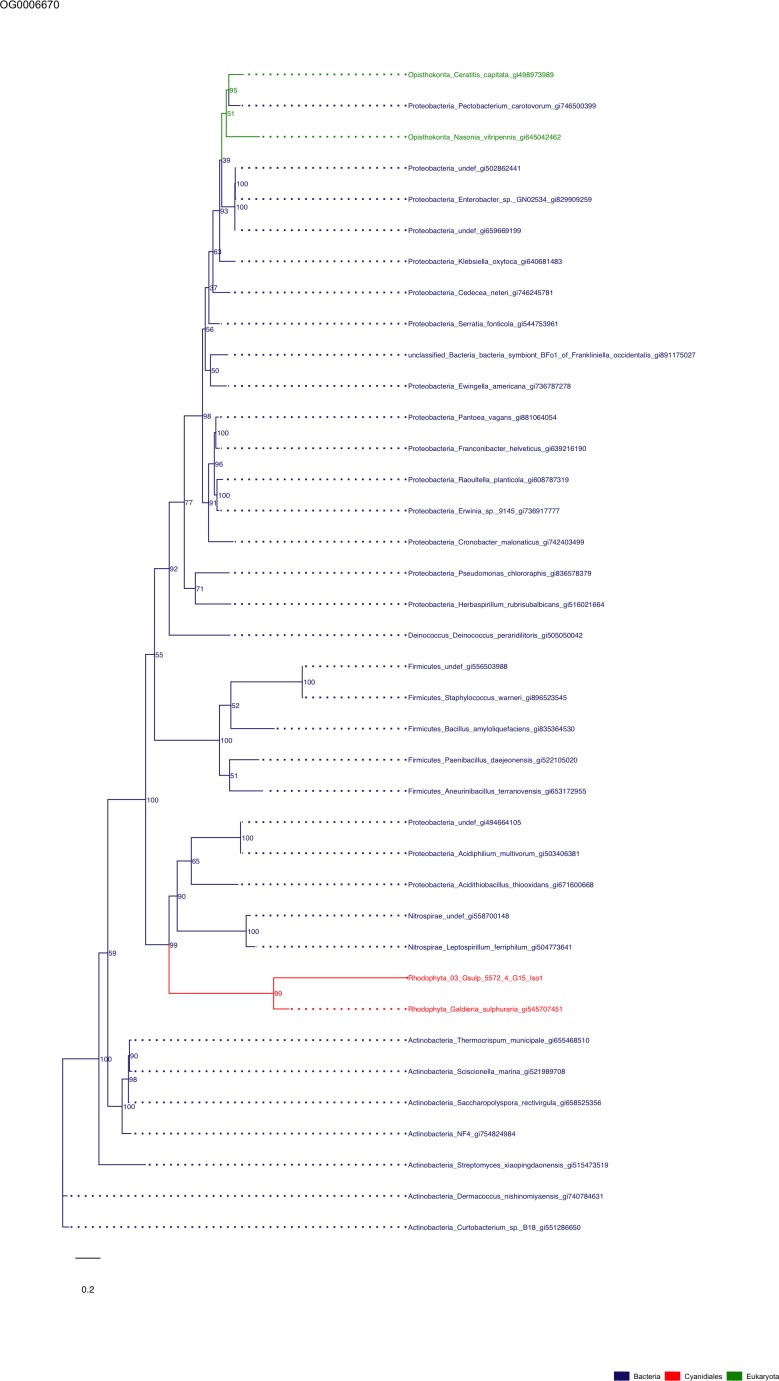
Sequence tree of orthogroup OG0006670.The tree is based on amino acid sequences. Archaea (yellow), Bacteria (blue), Cyanidiales (red), Eukaryotes including other red algae (green). Branches containing Cyanidiales sequences are highlited in red.